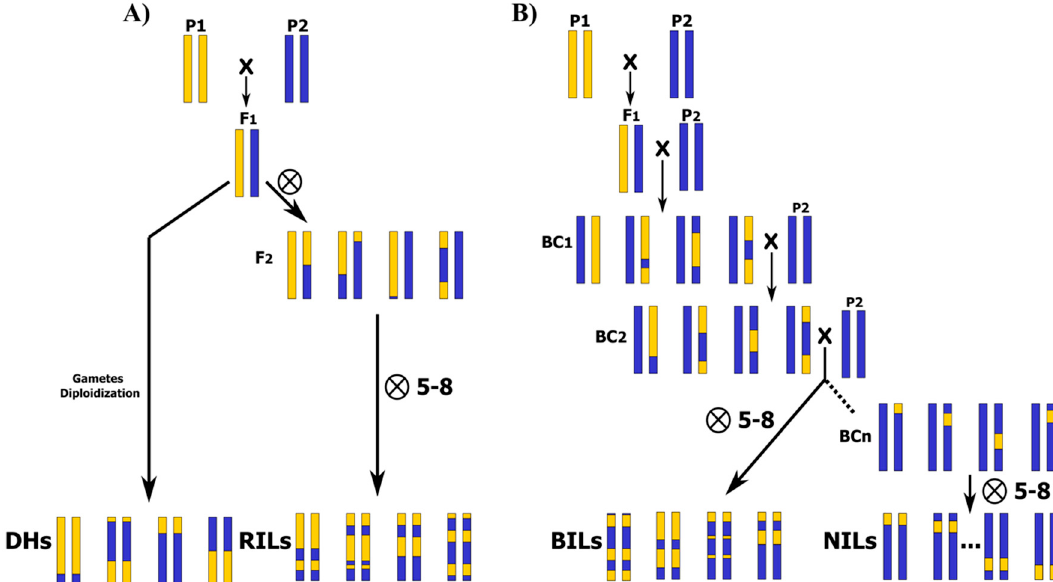
Figure 1. Bi-parental populations, from lowest to highest number of recombination events and required efforts in population development. Parental founders P1 and P2 are contrasting for the trait/s of interest, and F1 is the simple hybrid derived from founder cross: ( A ) Doubled haploids (DHs), F2, and recombinant inbred lines (RILs) developed by successive generations of selfing. ( B ) Backcross (BC), backcross inbred lines (BILs), and near isogenic lines (NILs) obtained by successive generations of selfing.